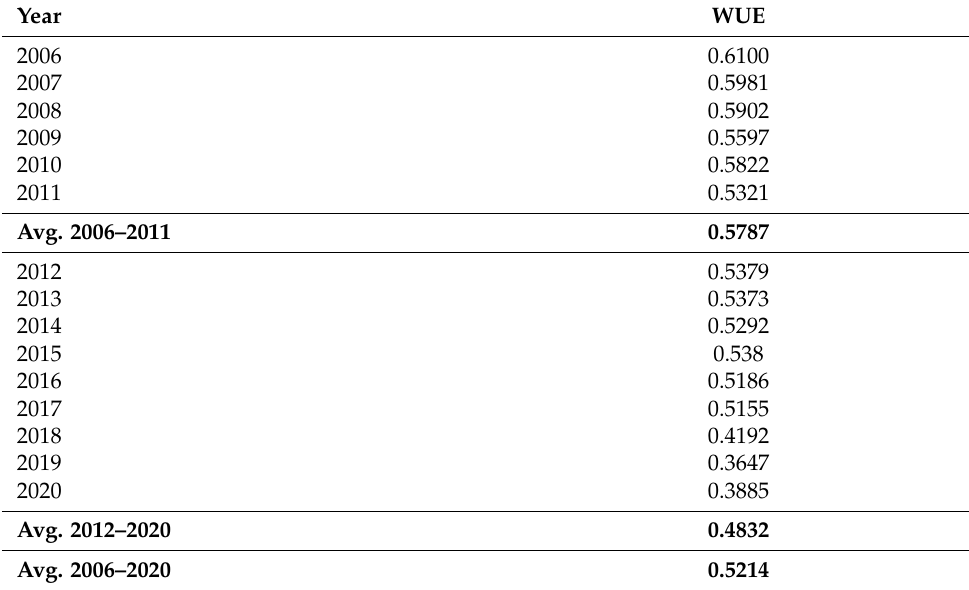
Figure 3. Average water usage efficiency level (2006–2020) grouped by province. Table 2. WUE difference in two study periods (2006–2011,